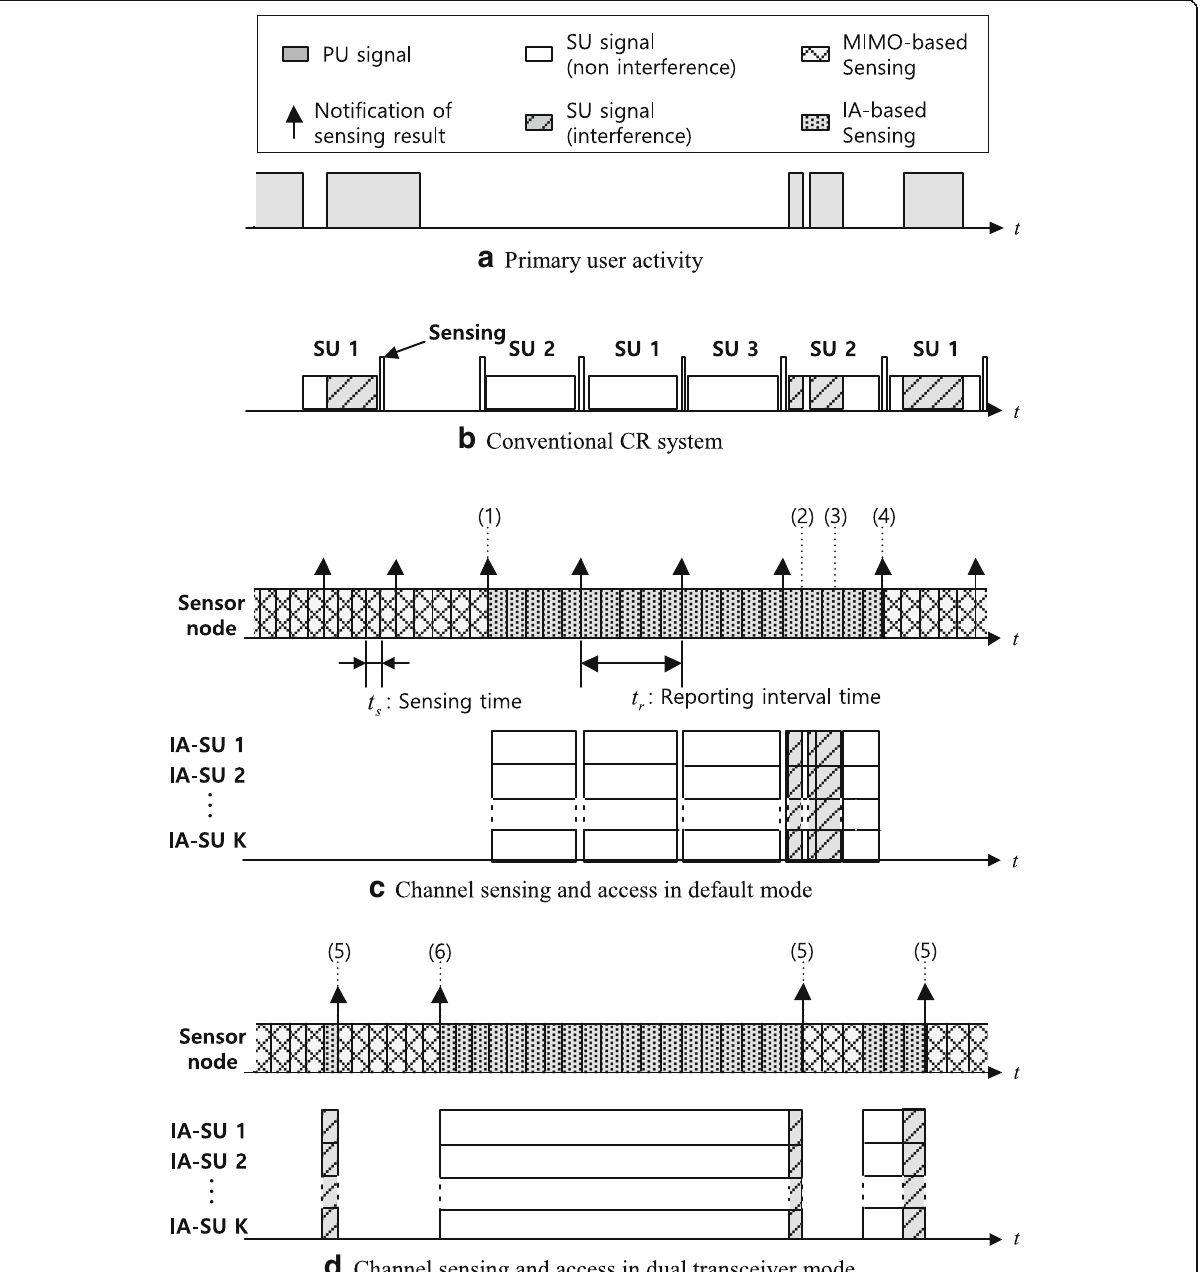
Fig. 3 Conventional CR system and proposed IA-based spectrum sensing. According to the busy/idle state of PU in a , this figure represents the process of conventional CR system in b , default mode in c , and dual transceiver mode in d . Since the conventional CR system can only sense the primary signal only during the short sensing time, the secondary system gives harmful interference to the primary system during the data transmission as shown in b . As shown in c , the sensor node can continuously sense the primary signal. At time (1), the sensor node broadcasts the primary non-detection report to SUs so that SUs can utilize the data channel using interference alignment. At time (2) and time (3), the sensor node detects the primary signal so that it sends the primary detection report at (4). As we can see in c , SUs can seize their transmission until the primary signal is not detected. d The case that dual transceivers are used. At time (5) when the sensor node detects the primary signal, it can immediately send the detection notification using the dedicated control